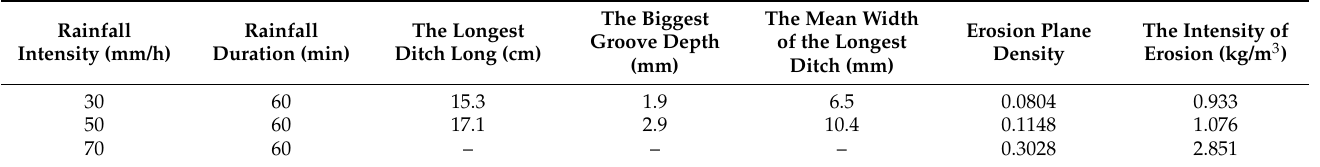
Table 3. Parameter values of black soil test